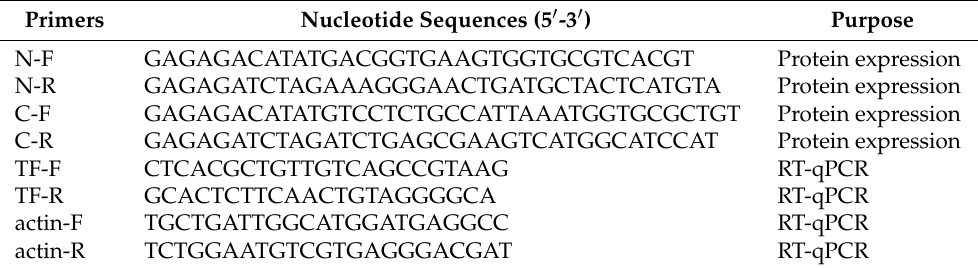
Table 1. Primers used in this